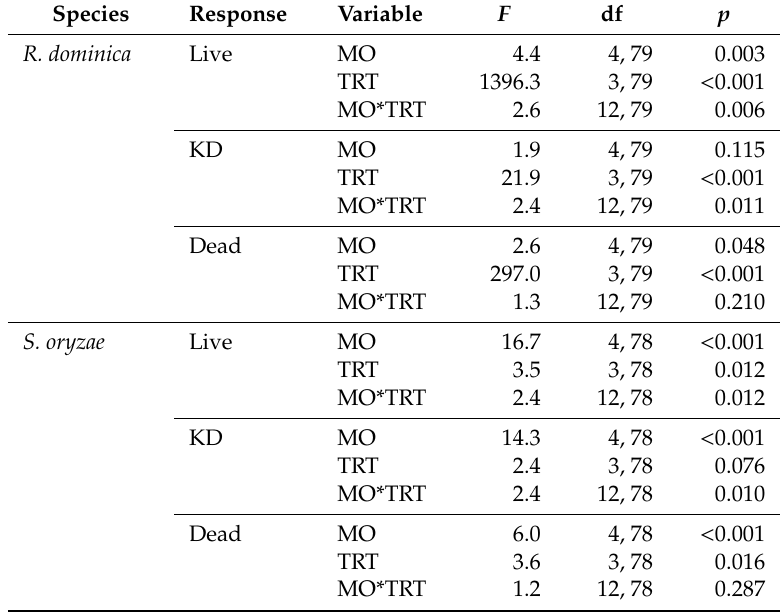
Table 11. ANOVA Table for main e ff ects month (MO), treatment (TR, untreated controls, two rates of Diacon IGR + , and the Gravista product) for the percentage of adult R. dominica and S. oryzae that